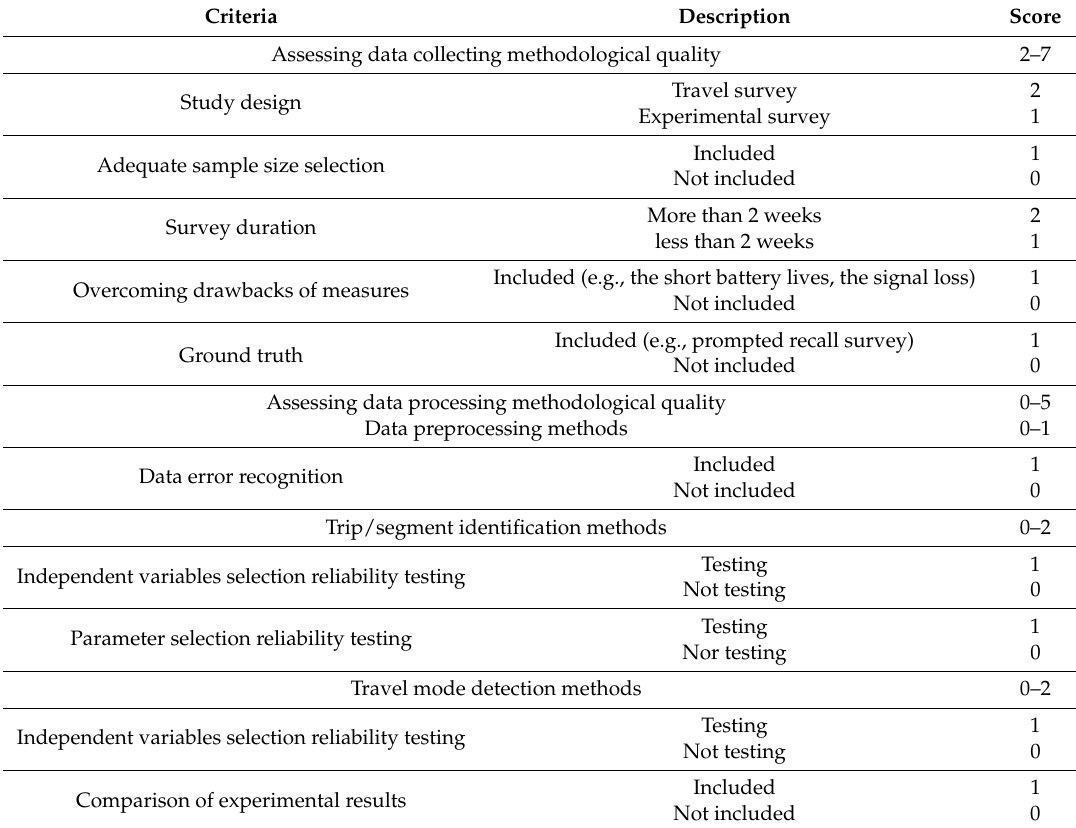
Table 1. Checklist for evaluating studies’